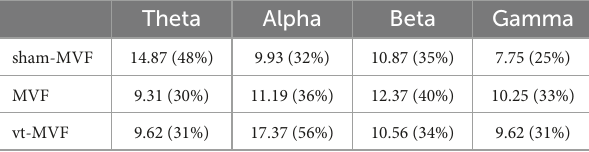
TABLE 1 Binarization threshold of brain networks in different frequency bands and the corresponding node